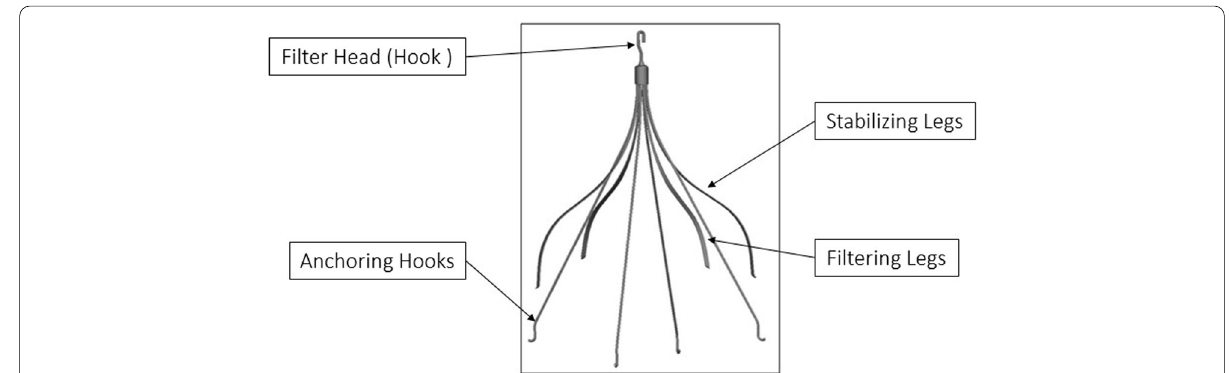
Fig. 4 VenaTech ® Retrievable